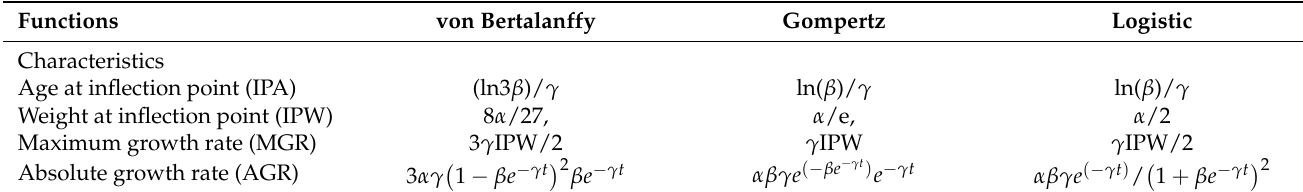
Table 1. The growth functions used to estimate the growth curve